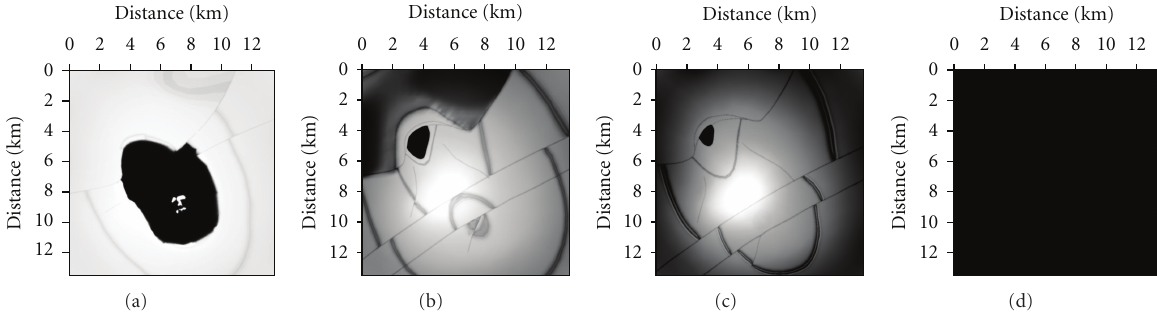
Figure 4: EAGE/SEG salt model. Representation by 4 horizontal cuts at z = 1 . 7 km, z = 2 . 9km, z = 3 . 5 km, and z = 4 . 1km (from (a) to